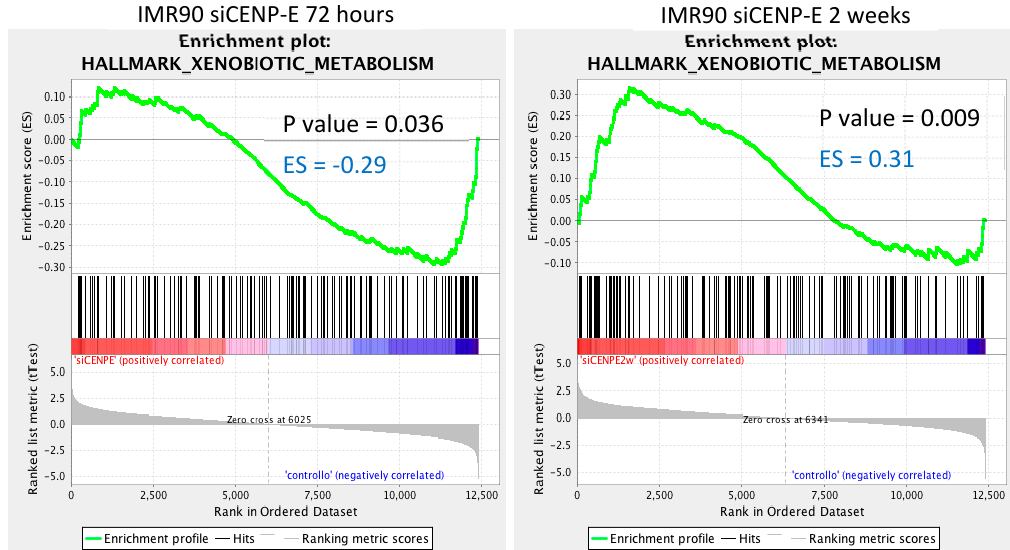
Figure 3. Enrichment plots of the significantly enriched xenobiotic metabolism gene set shared by the two samples. The y -axis show the enrichment scores (ES) and the x -axis shows gene members for the two gene sets. The green line connects points between ES and genes. ES represent the amount to which a gene is over-represented in a gene set. The coloured bands represent positive (red) or negative (blue) degrees of correlation of genes with the siCENP-E (72 h or 2 w) phenotype. The xenobiotic metabolism gene set was negatively correlated (ES = − 0.29) with the early siCENP-E timepoint; 26 of 145 genes from this set were downregulated at 72 h with respect to the control. Conversely, the xenobiotic metabolism gene set was positively correlated (ES = 0.31) with the late siCENP-E timepoint and 34 of 145 genes from this set were upregulated at 2 weeks with respect to the control (Tables S5 and S6). Significance threshold set at p -value < 0.05. The enrichment plots were derived from GSEA tool [21]. Table 3. Hallmark mitotic-spindle-enriched genes in IMR90 siCENP-E 72 h